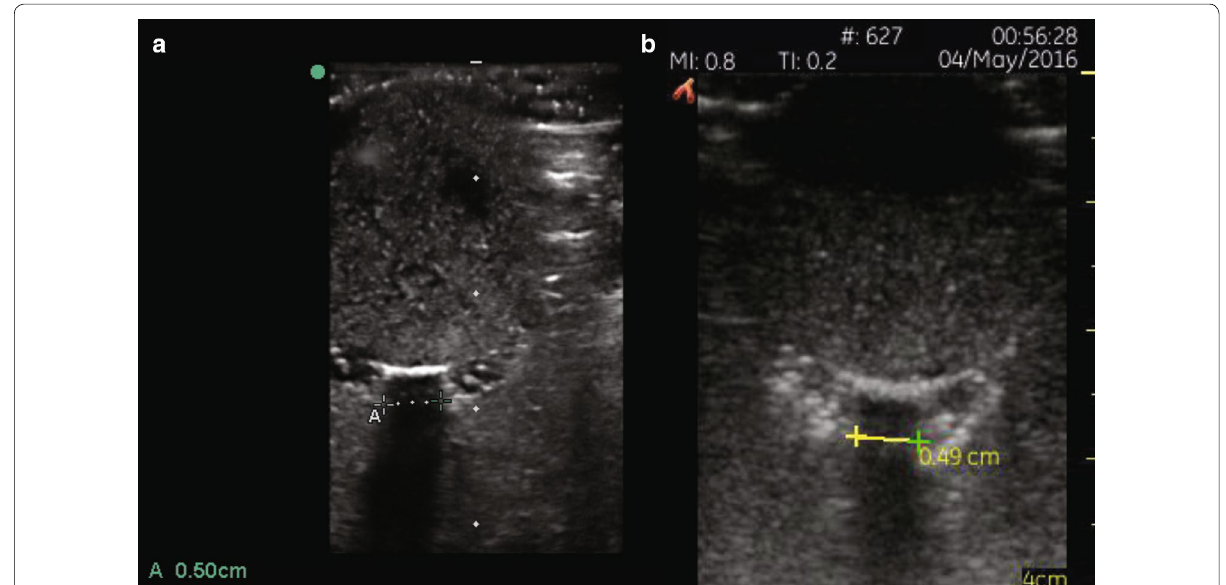
Fig. 1 Ultrasound images of ONSD measurements utilizing the SonoSite ( a ) and Vscan ( b ) ultrasound units